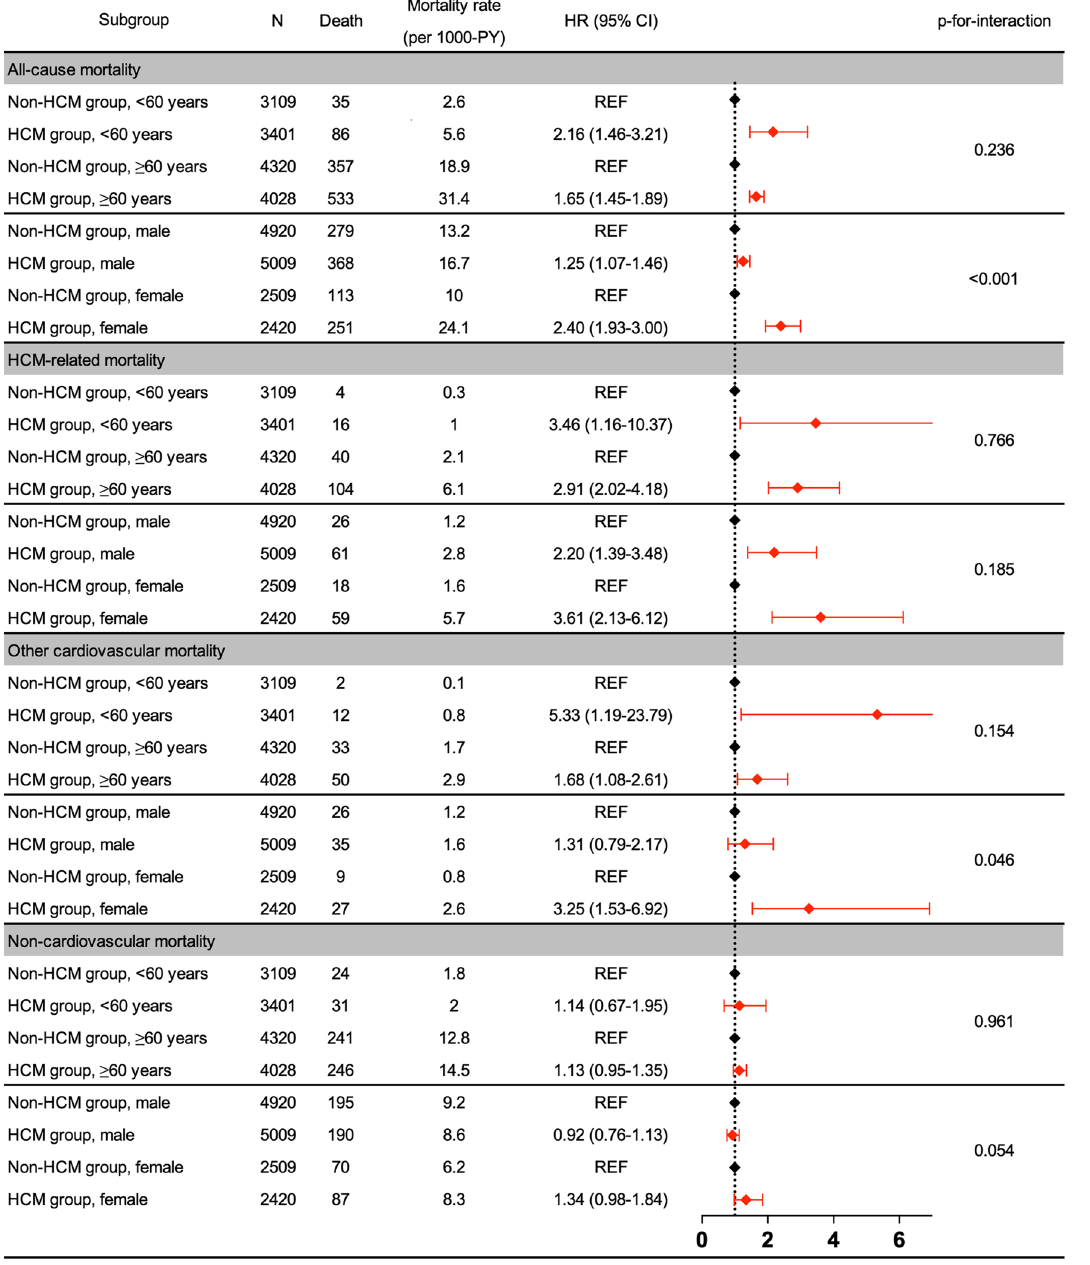
Figure 4. Subgroup analyses. PY person-year, HR hazard ratio, CI confidence interval, HCM hypertrophic cardiomyopathy, REF